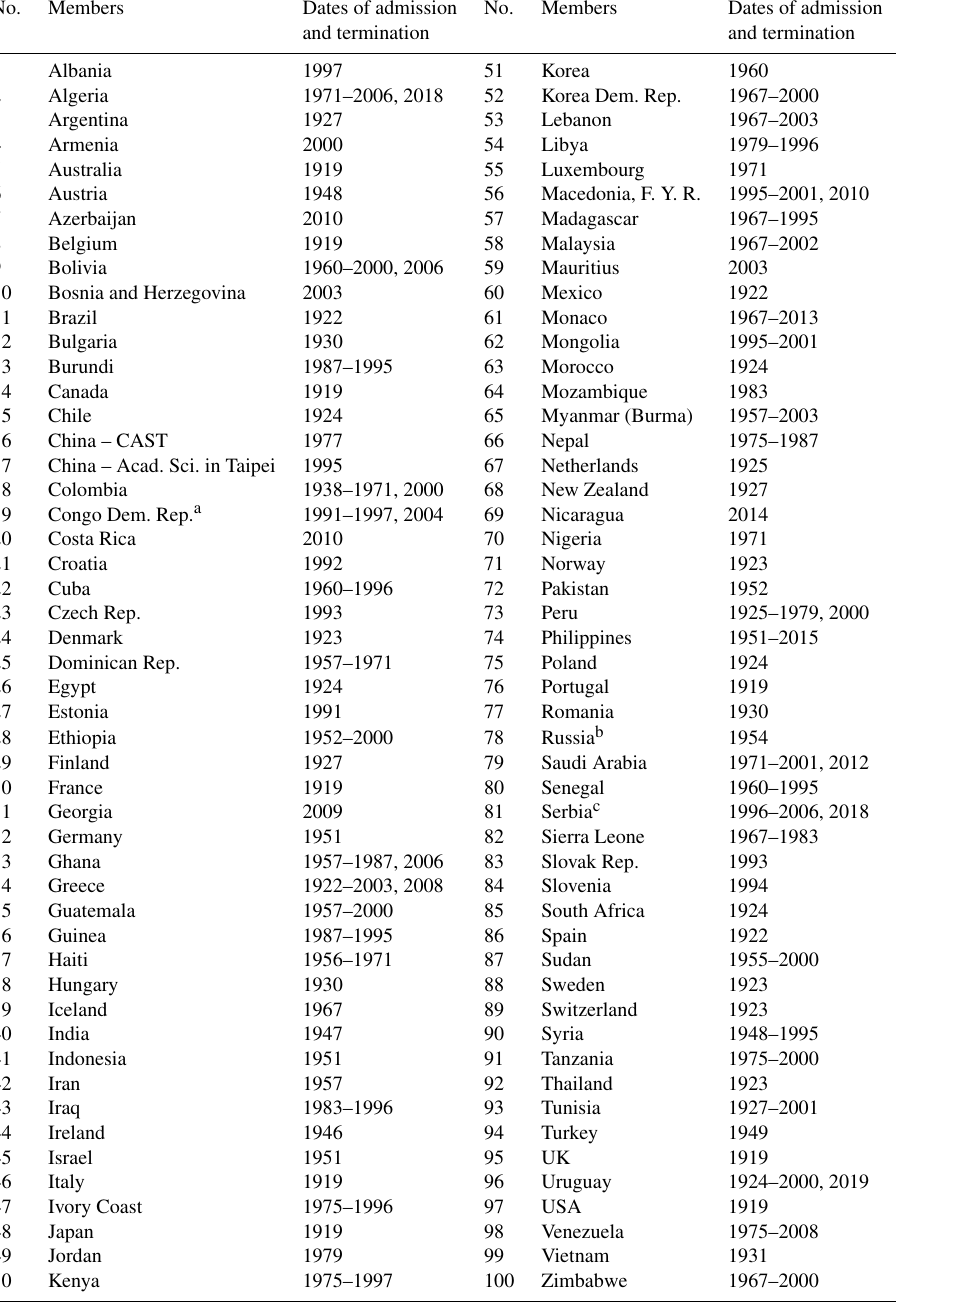
Table A1. Member Adhering Bodies of IUGG